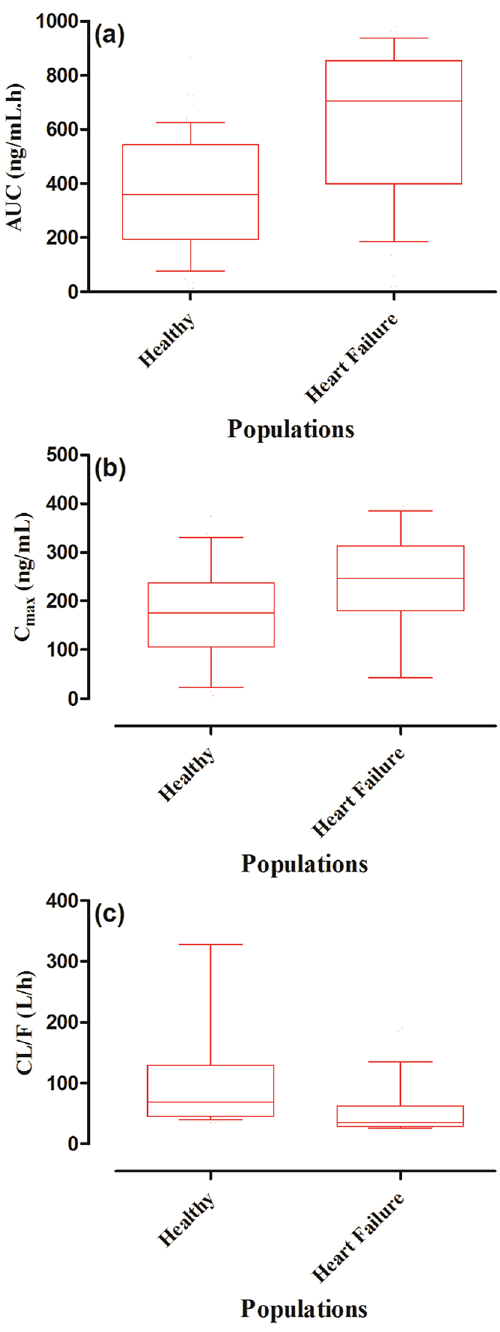
Figure 8. Box plots showing the median, 25th–75th, and 10th–90th percentiles for AUC, C max, and CL in the CHF population. ( a ) Area under the curve from time 0 to the infinity (AUC 0–∞ ), ( b ) maximum systemic concentration (C max ), and ( c ) the oral clearance (CL/F) in healthy and chronic heart failure